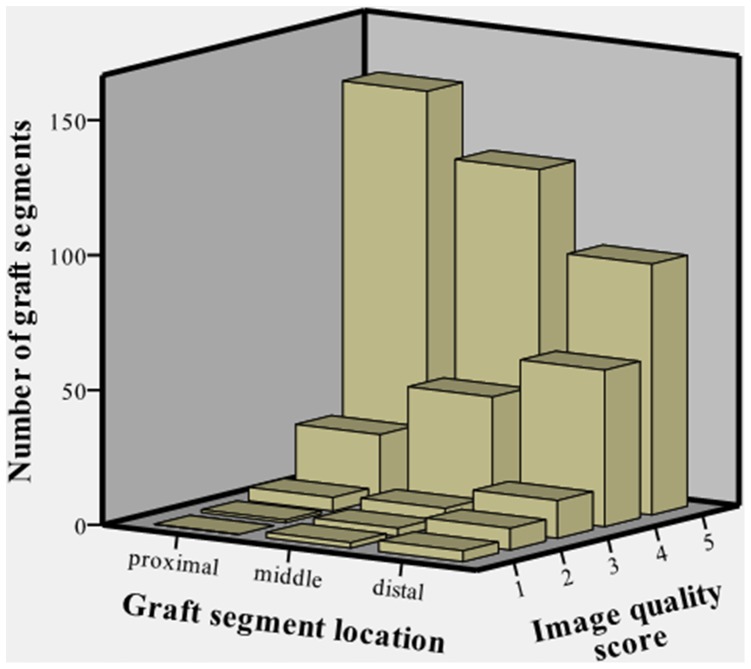
Distribution of image quality score according to coronary artery graft segment location.Bar chart shows the analysis of the image quality score distribution for proximal, middle and distal segments of 177 grafts with cephalic to caudal orientation (531 graft segments). Distal graft segments were associated with significantly lower image quality scores than proximal segments.